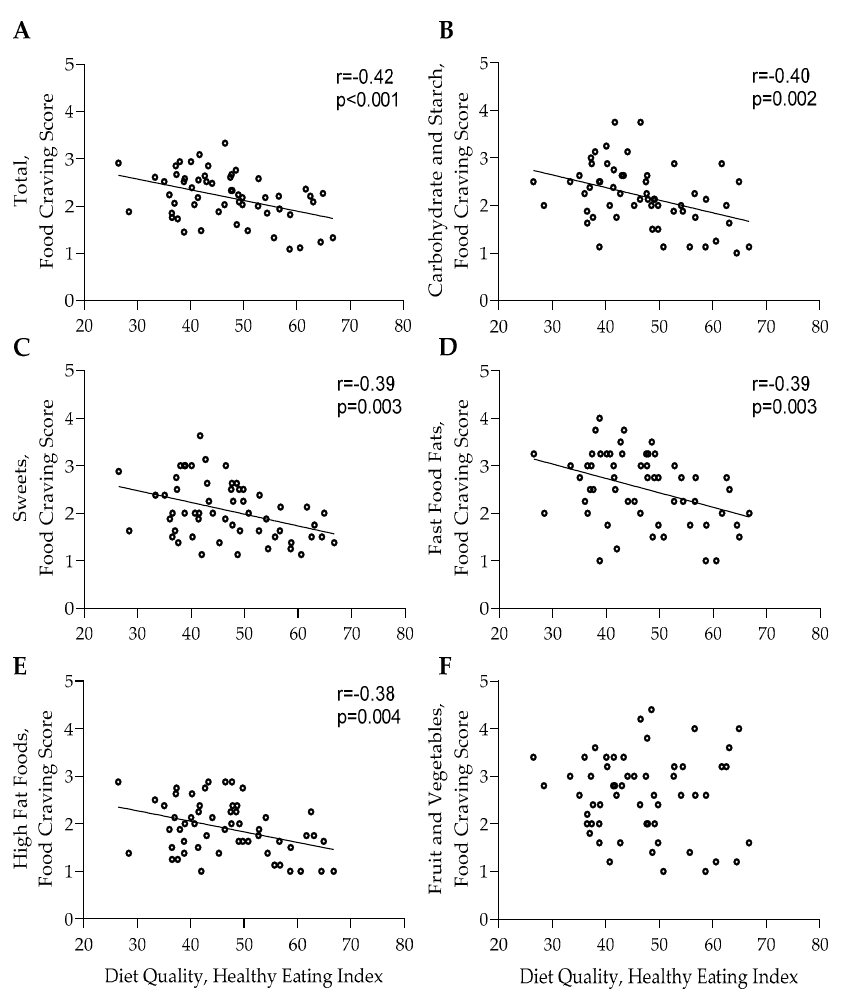
Figure 2. Food Cravings and Diet Quality. Food cravings scores are reported per individual in relation to their respective Healthy Eating Index. Cravings are reported as ( A ) total cravings and as cravings for ( B ) Carbohydrates and Starch, ( C ) Sweets, ( D ) Fast Food Fats, ( E ) High Fat Foods and ( F ) Fruit and Vegetables. Significant associations are indicated by linear regression.